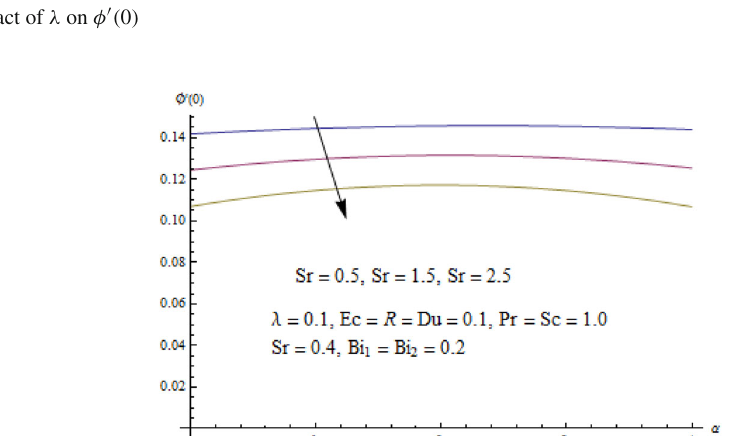
Fig. 29 Impact of λ on φ (cid:5) ( 0 )